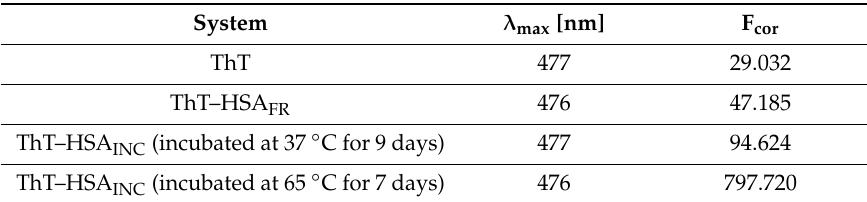
Table 1. ThT fluorescence (1 × 10 − 5 mol · L − 1 ) in the absence and presence of HSA FR and HSA INC